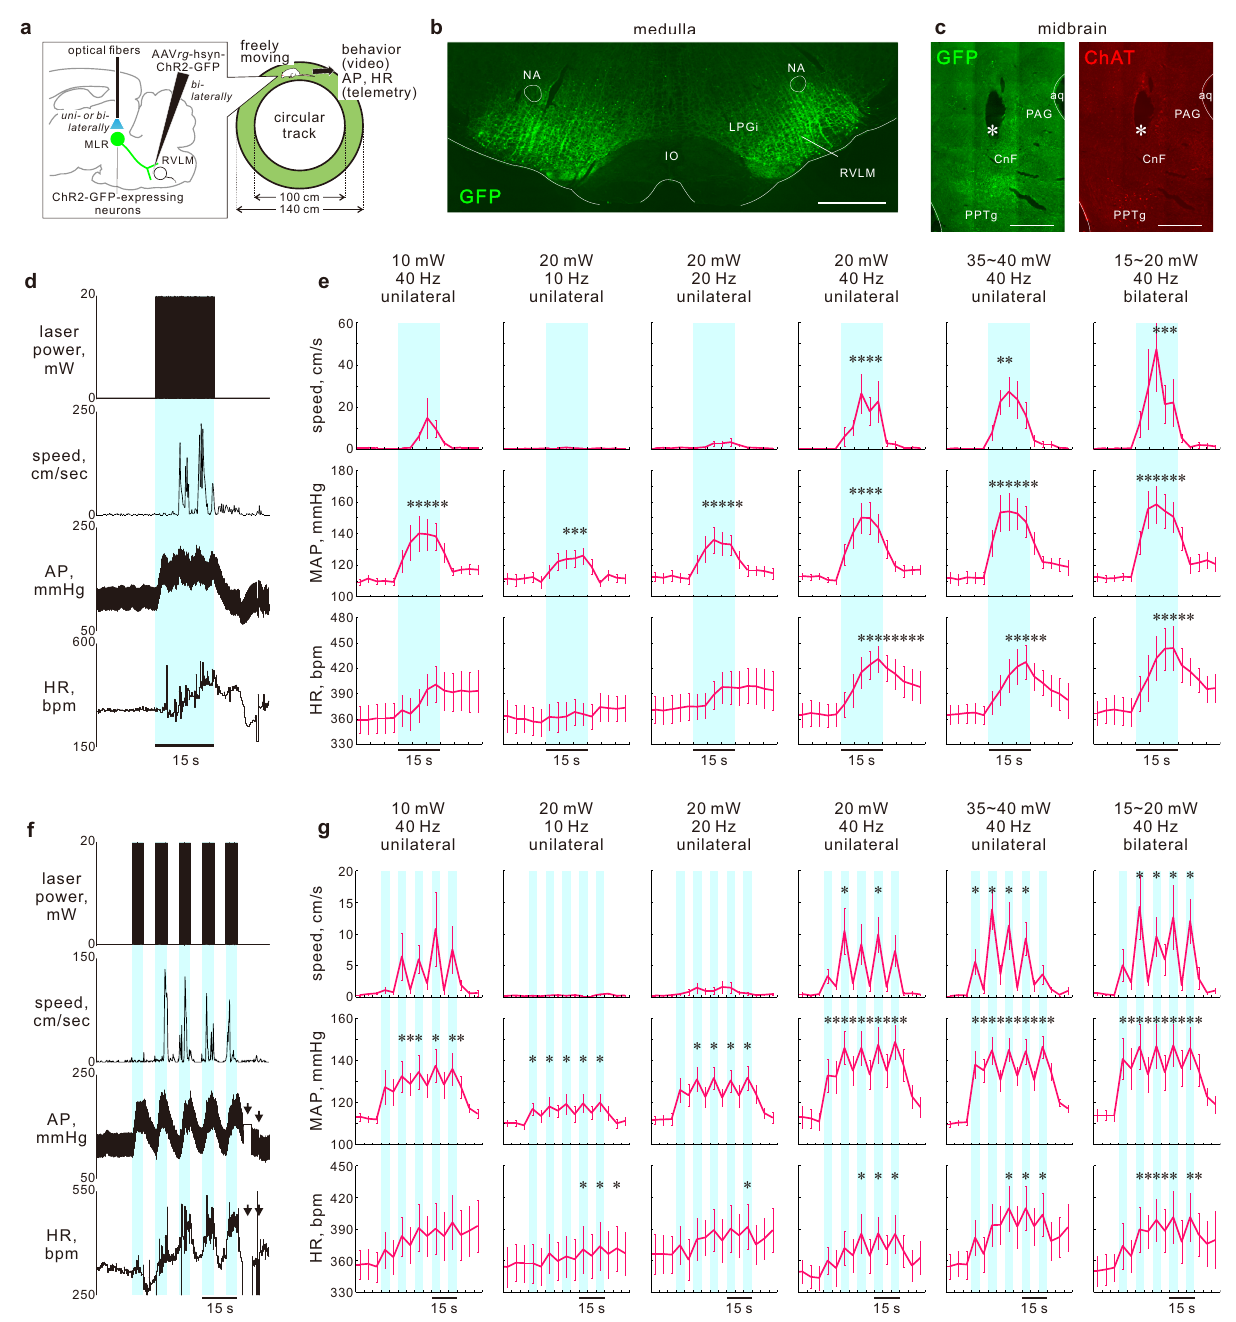
Fig. 4 | Locomotion and cardiovascular responses driven by the MLR → RVLM pathway.a Optogeneticstimulation ofMLR → RVLM neuronsinconsciousratsleft free to move on a circular track. b GFP transduction in the axonal fi bers of the medulla of a ChR2-GFP-expressing rat (auto fl uorescence). Scale bars: 1mm. c GFP and ChAT-immunoreactive cells in the midbrain. Asterisks: a location of the implanted optic- fi ber tip. Scale bars: 1mm. d Representative recording during 15-s sustained optogenetic intervention (40Hz; 20mW) in a ChR2-GFP-expressing conscious rat. e Time course (3-s bins) changes in response to 15-s sustained optogenetic stimulation ( n =8, besides n =7 for bilateral stimulation, all males). Tracings of each rat are presented in Supplementary Fig. 4a. f Representative recording during fi ve-time-repeated intermittent (5-s laser-on/5-s laser-off) opto- genetic interventions (40Hz; 20mW) in a ChR2-GFP-expressing conscious rat. Arrows: disconnection of telemetry signals. This recording was included in the